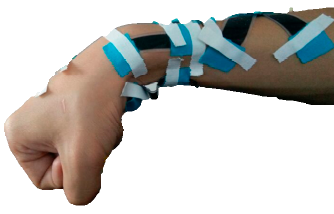
Figure 8. Wrist joint move to a certain position.